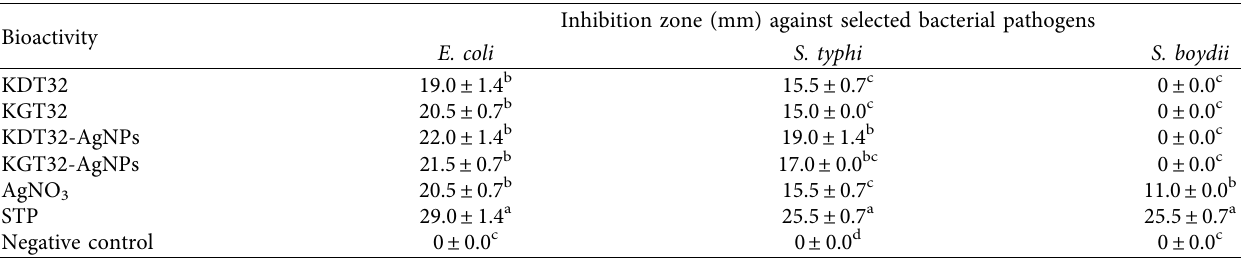
Table 1: Evaluation of the antibacterial activity of actinomycete metabolite-mediated AgNPs against selected bacteria pathogens.